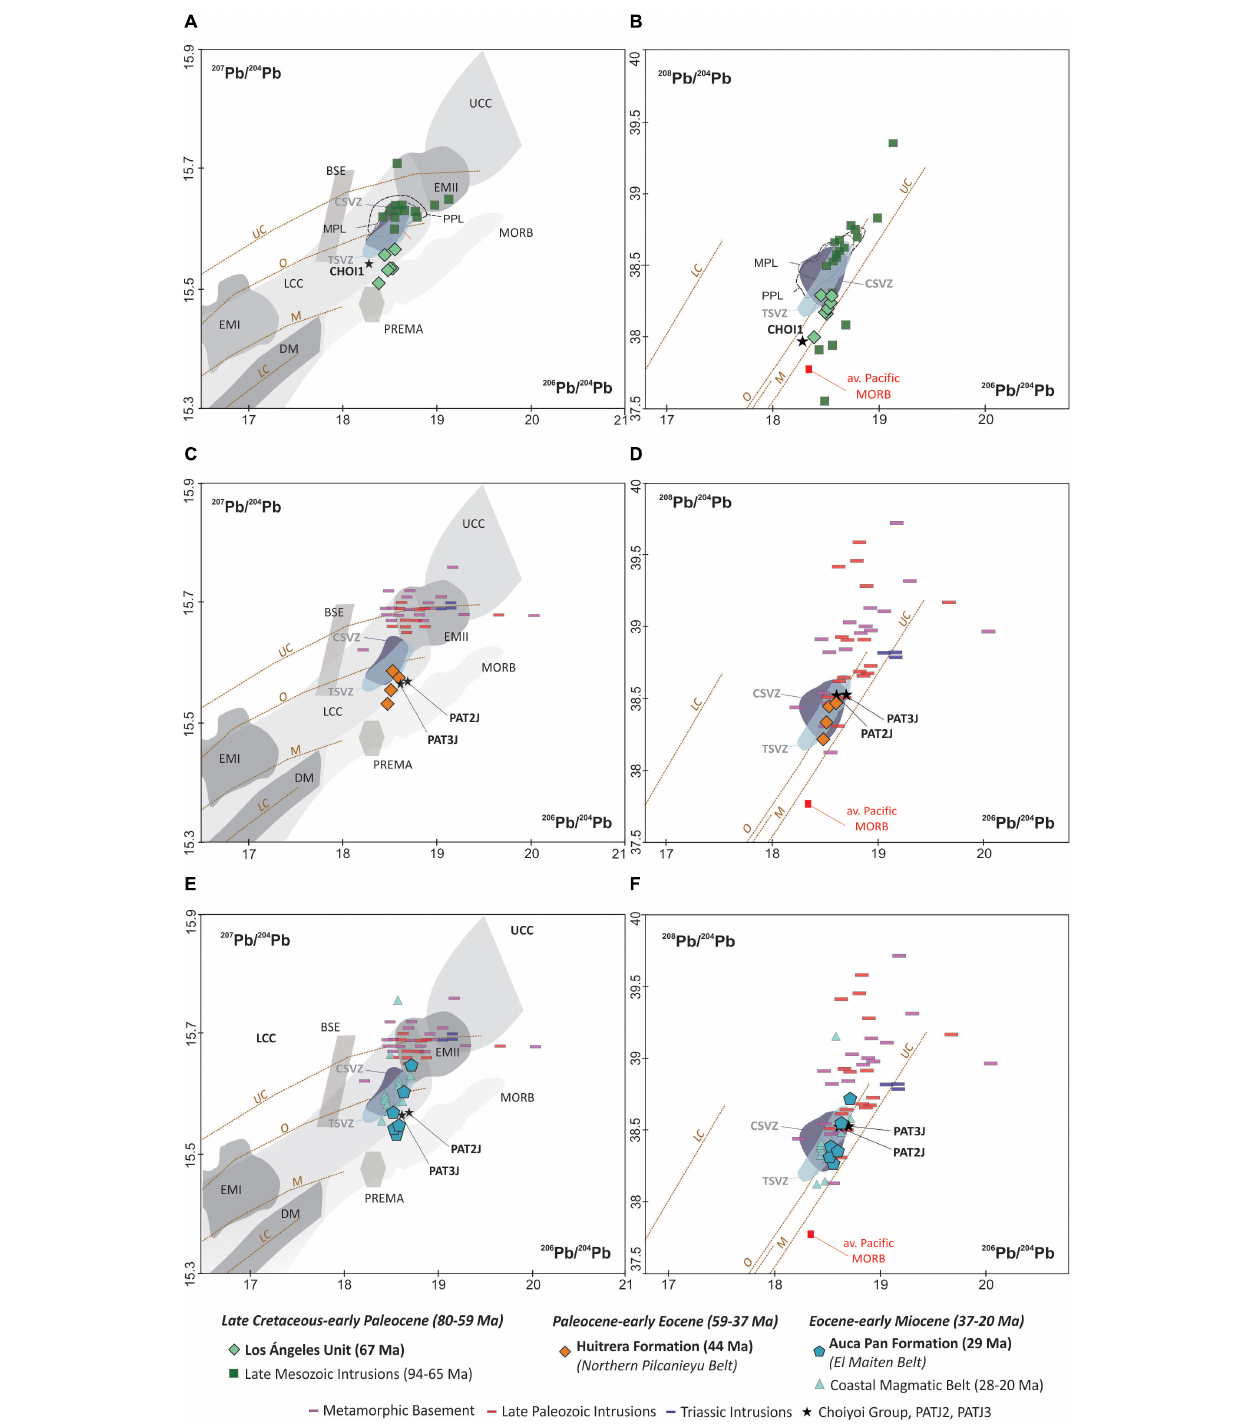
FIGURE 8 | Pb isotopic composition for the Late Cretaceous–early Paleocene Los Ángeles Unit (A,B) , the Eocene Huitrera Formation (C,D) and the Oligocene Auca Pan Formation (E,F) . The fields of the isotopic composition of the different mantle reservoirs are as in Zindler and Hart (1986): upper and lower continental crust (UCC and LCC), depleted mantle (DM), bulk silicate earth (BSE), mantle with high U/Pb ratio (HIMU), enriched mantle I (EMI), enriched mantle II (EMII), and observed prevalent mantle composition (PREMA). Moreover, we also included the isotopic composition of mid-ocean ridge basalt (MORB) and the average Pacific MORB from Lucassen et al. (2001), Neogene Patagonian main and post-plateau lavas from Gorring and Kay (2001), and the compositional fields for the TSVZ and CSVZ from López-Escobar et al. (1992, 1995) and Mella et al. (2005). Figures also include the lead-isotope evolution curves from the plumbotectonic model presented by Zartman and Doe (1981) for the mantle (M), the orogen (O), the upper crust contributed to the orogen (UC), and the lower crust contributions to the orogen (LC).